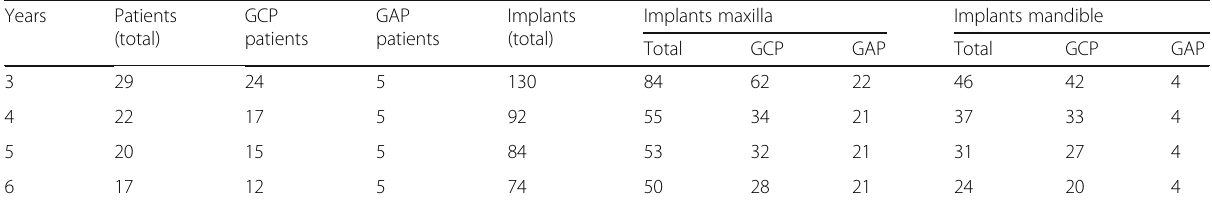
Table 2 Observation period (patient and implant related) Years Patients